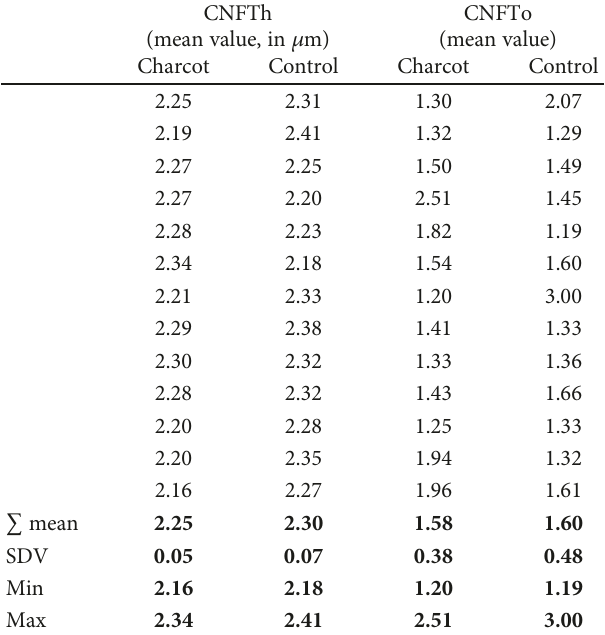
Table 2: Average weighted corneal nerve fi bre thickness (CNFTh), measured as mean thickness perpendicular to the nerve fi bre course ( μ m) and average weighted corneal nerve fi bre tortuosity (CNFTo), re fl ecting variability of nerve fi bre directions, de fi ned as total absolute nerve fi bre curvature in both